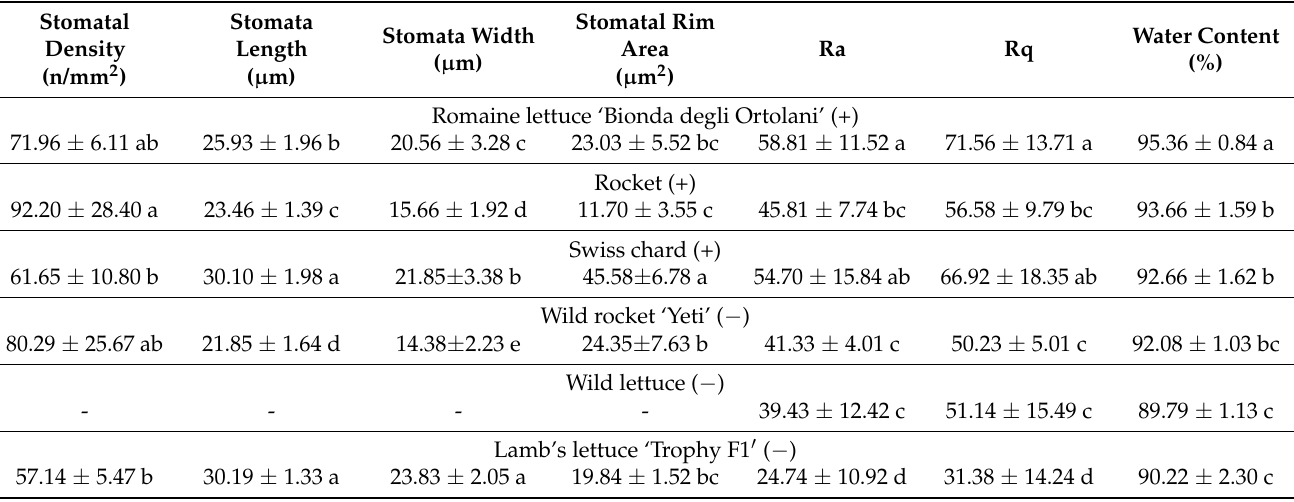
Table 3. Stomatal parameters (density, length, width, rim area), roughness (Ra and Rq) of adaxial leaf surface and water content (%) in six selected accessions of baby leaves (+ = most susceptible to contamination; — = less susceptible).